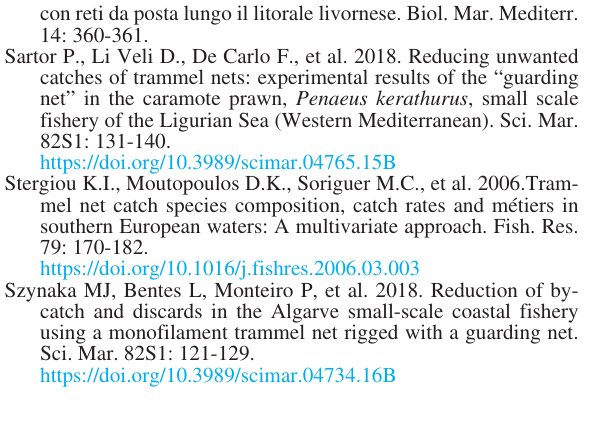
Fig. S1. – Effect of trammel net modification on main commercial species. Contrasts between standard trammel net and trammel net with a guarding net. Fig. S2. – Effect of trammel net modification on the main commer- cial species. Contrast between standard trammel net and tram- mel et modified with head rope